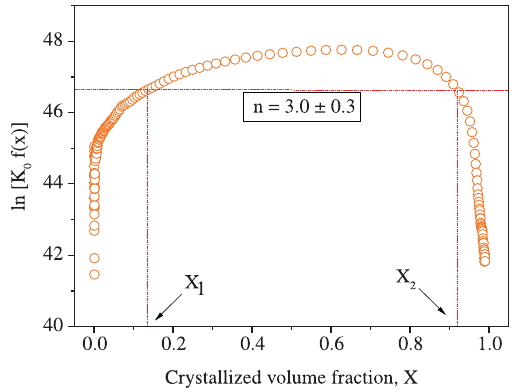
f ( x )] versus x at a heating rate of 3 °C/min. The Figure 6. ln[ K 0 dotted lines indicate a pair of volume fractions ( x f ( x )] has the same value. From these x ln[ K 0 Avrami coefficient was calculated using Equation